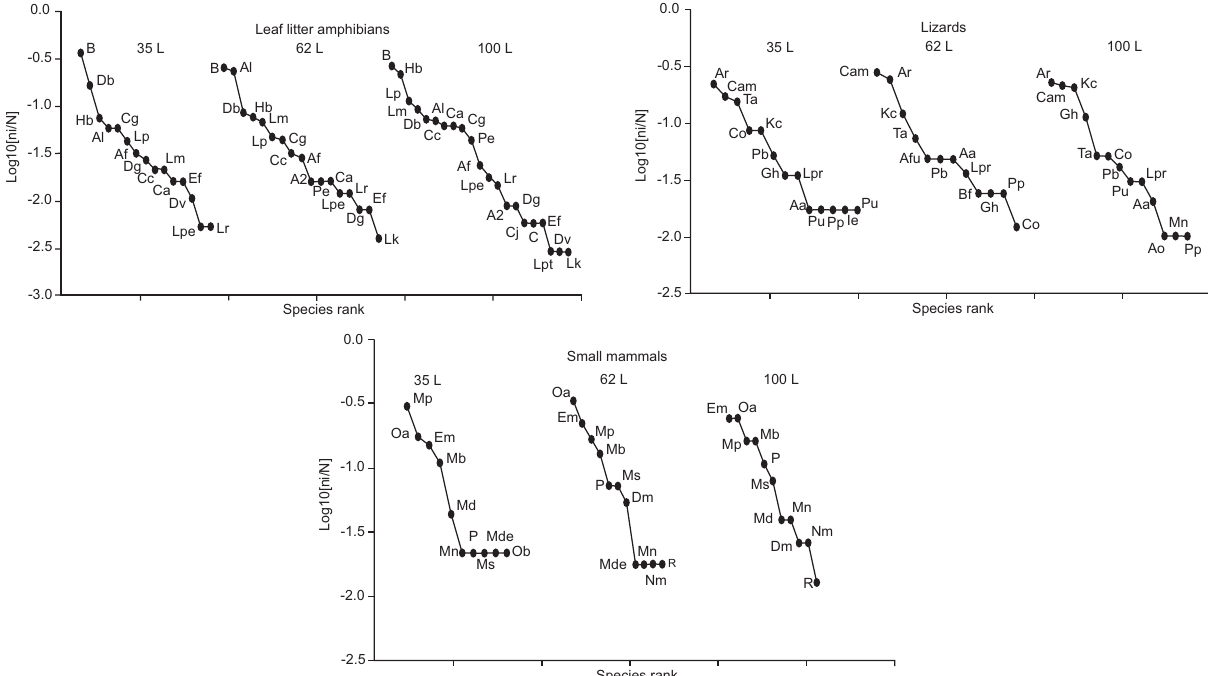
Figure 6. Leaf litter amphibian, lizard and nonvolant small mammal species rank-abundance curves (Whittaker plots) registered by 35, 62, and 100 L pitfall traps. Abbreviation of species names are given on table I.